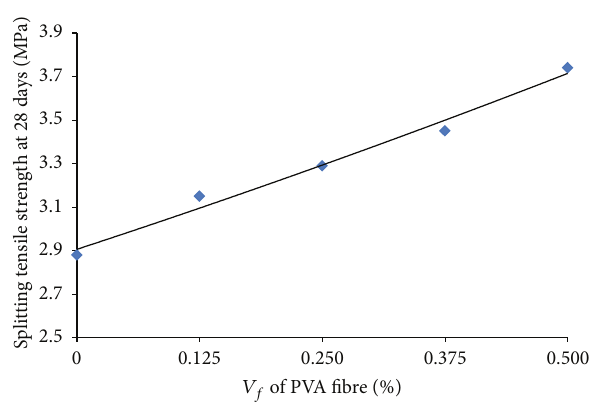
Figure 10: Relationship between PVA fiber volume fraction and splitting tensile strength.